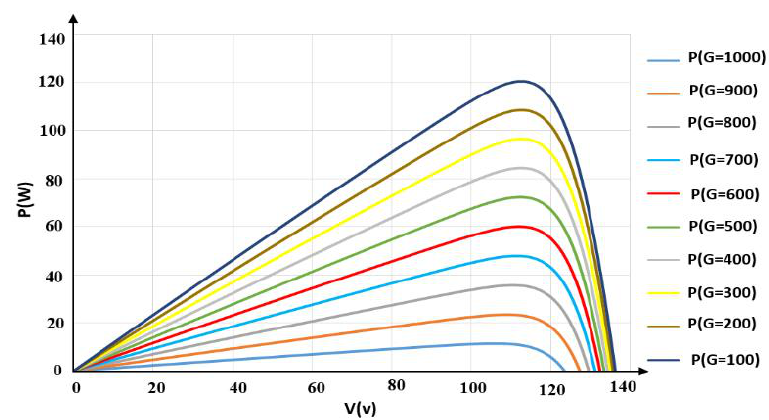
Figure 3. The PV array’s P-V curves at various irradiation levels.